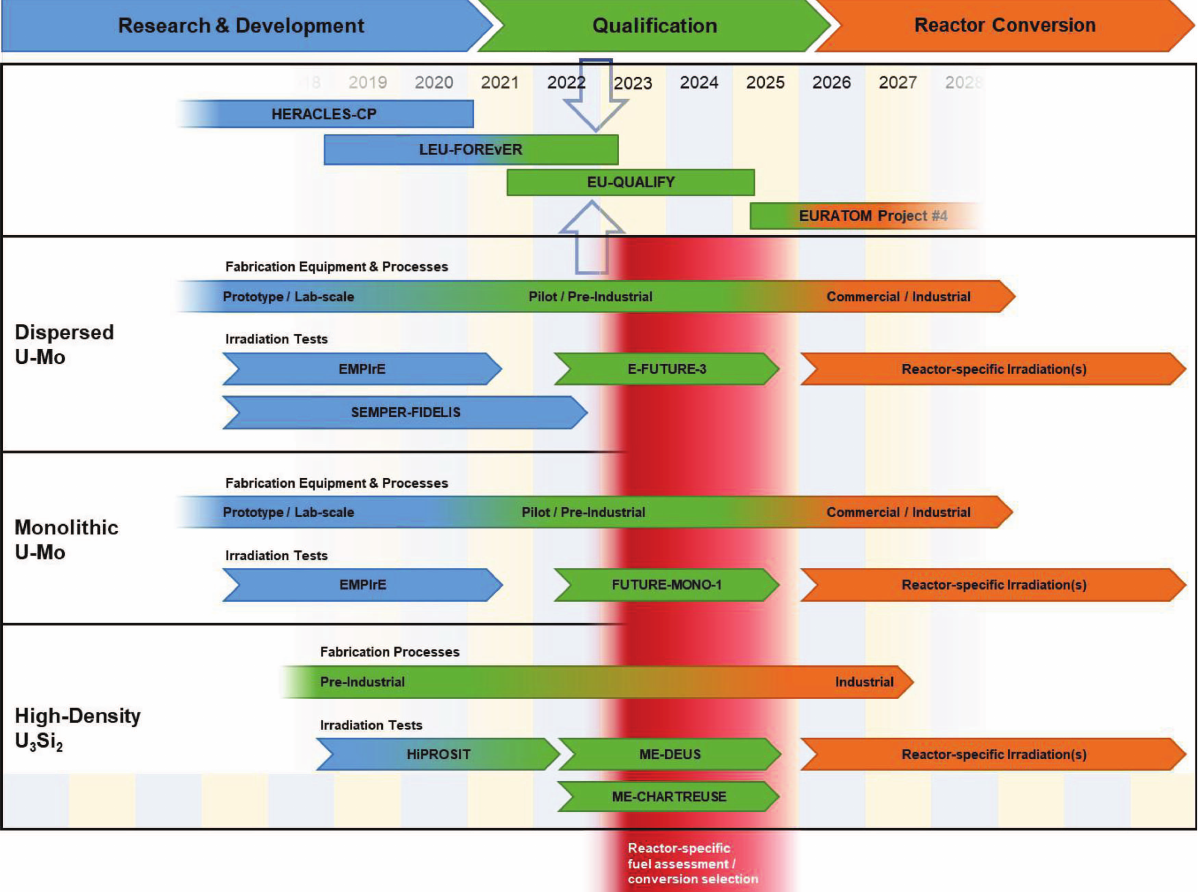
Fig. 1. The HERACLES consortium program with planned irradiation campaigns for advanced research reactor fuels. The LEU-FOREvER and EU-QUALIFY projects are indicated with